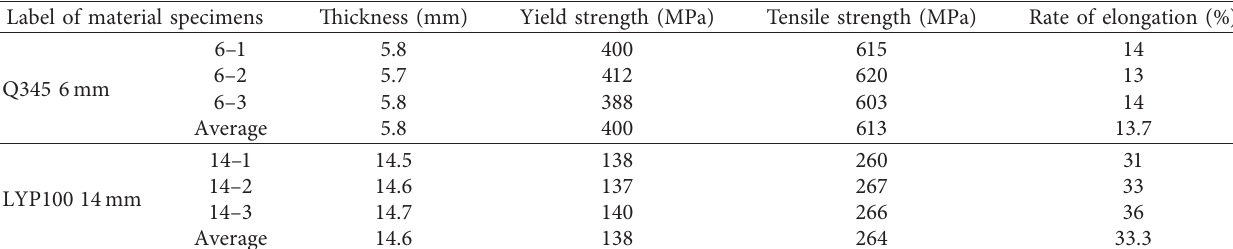
Figure 6: Photographs of the material specimens. (a) Before stretching. (b) After fracture. Table 2: Test results of steel material